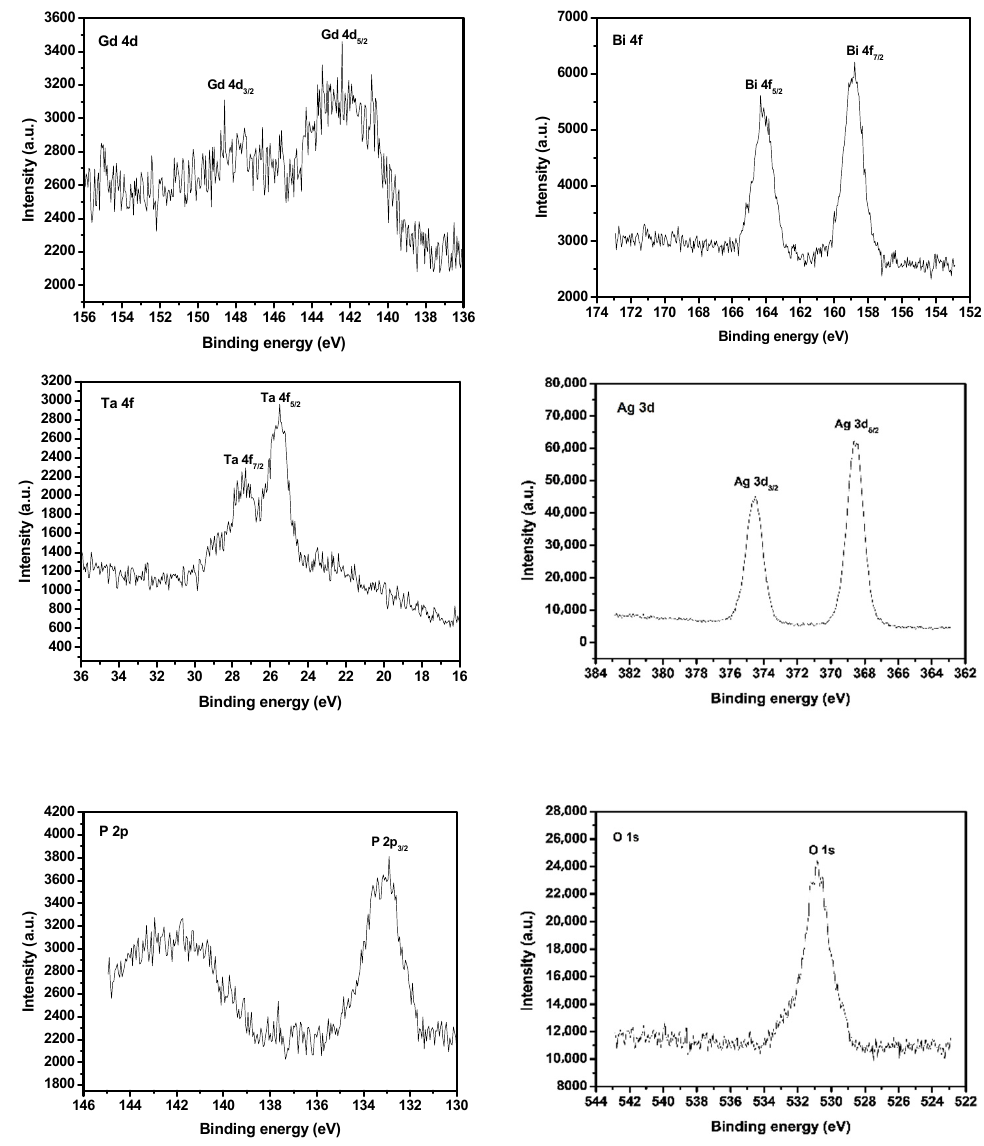
Figure 22. XPS spectra of O 2 − , Ag + , P 5+ , Gd 3+ , Bi 3+ and Ta 5+ from the Ag 3 PO 4 /Gd 2 BiTaO 7 heterojunction photocatalyst before the reaction of photocatalytic degradation of bisphenol A.